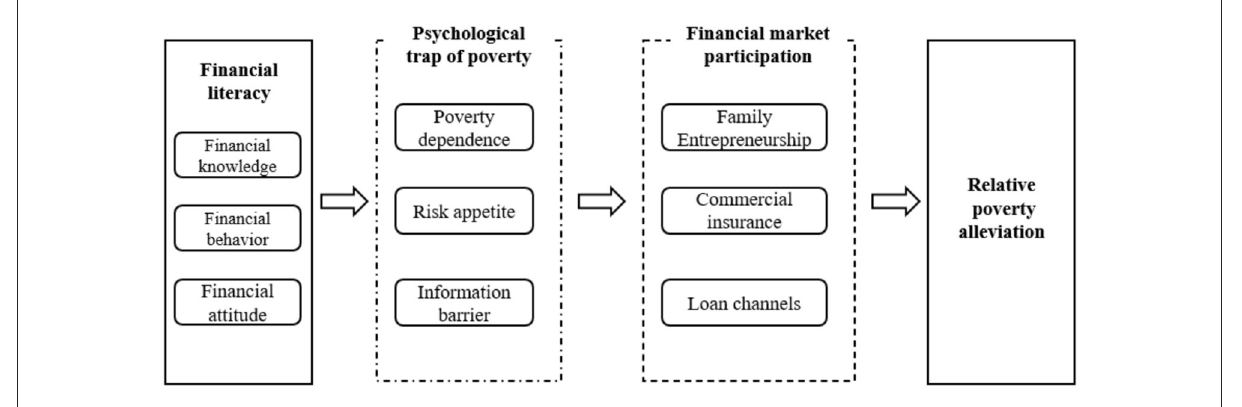
FIGURE1 Mechanism of household financial literacy alleviating relative